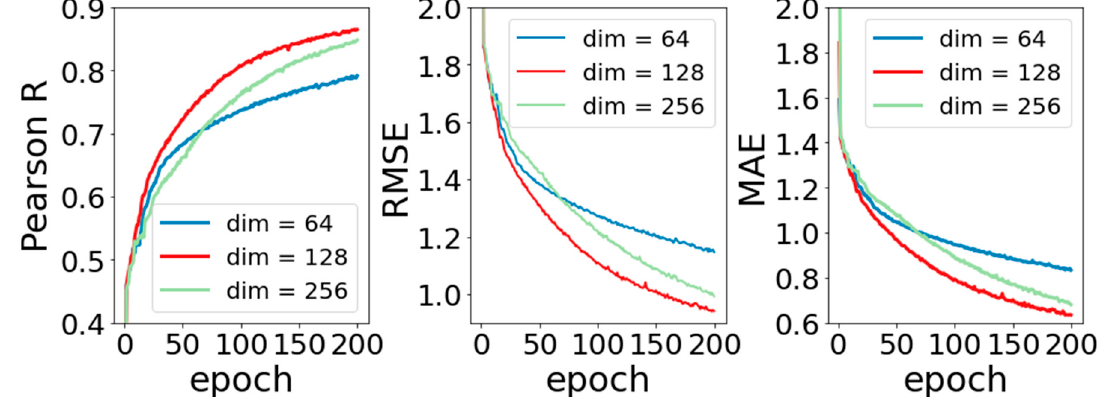
Figure 2. Curves of Pearson R, Root Mean Square Error (RMSE), and Mean Absolute Error (MAE) for different dimension.